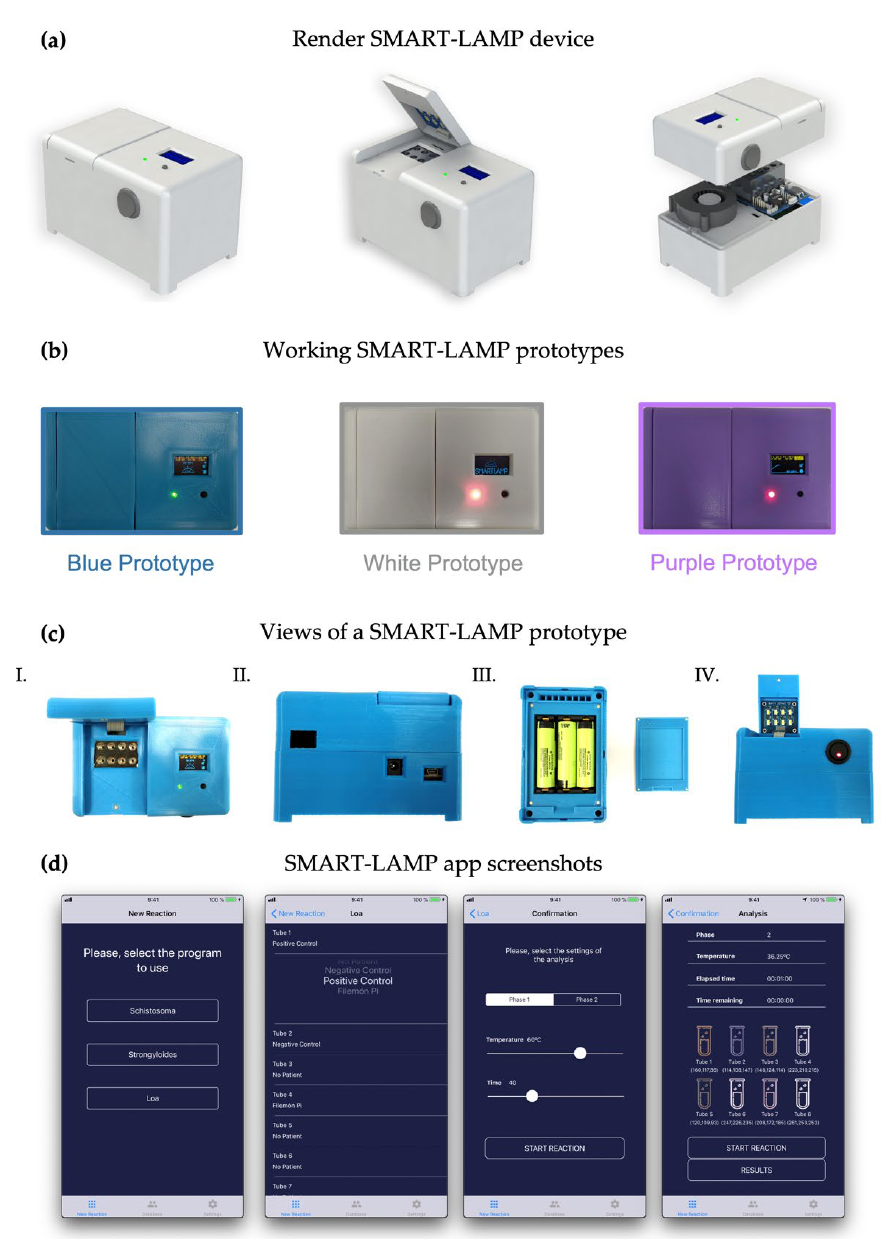
Figure 1. Design and principal features of the SMART-LAMP and SMART-LAMP app: ( a ) Render of the SMART-LAMP prototype with SolidWorks. From left to right: closed SMART-LAMP; SMART-LAMP with the lid of the incubation module opened; and internal structure of the SMART-LAMP prototype; ( b ) Top view of the three working SMART-LAMP prototypes used; ( c ) Different views of the one SMART-LAMP device: I. Top view of the SMART-LAMP device with the incubation module lid opened; II. Posterior view with all ports and device connections exposed, from left to right: fan opening, power supply port and USB port for computer connection; III. Inferior view with the exposed MC73831T and three Li-ion batteries that power the SMART-LAMP device. To the right, the lid used to cover the batteries which is magnetically attached to the device for easy removal and reinstalment; IV. Frontal view of the SMART-LAMP with the lid opened, exposing the overhead with LED used to illuminate samples while RGB measures are taken; ( d ) SMART-LAMP app screenshots. From left to right: reaction program selection, sample identification, duration and temperature setup through sliding buttons, interface of the SMART-LAMP app while a reaction is being carried out, showing the temperature of the device, the time elapsed and the RGB measurements of each